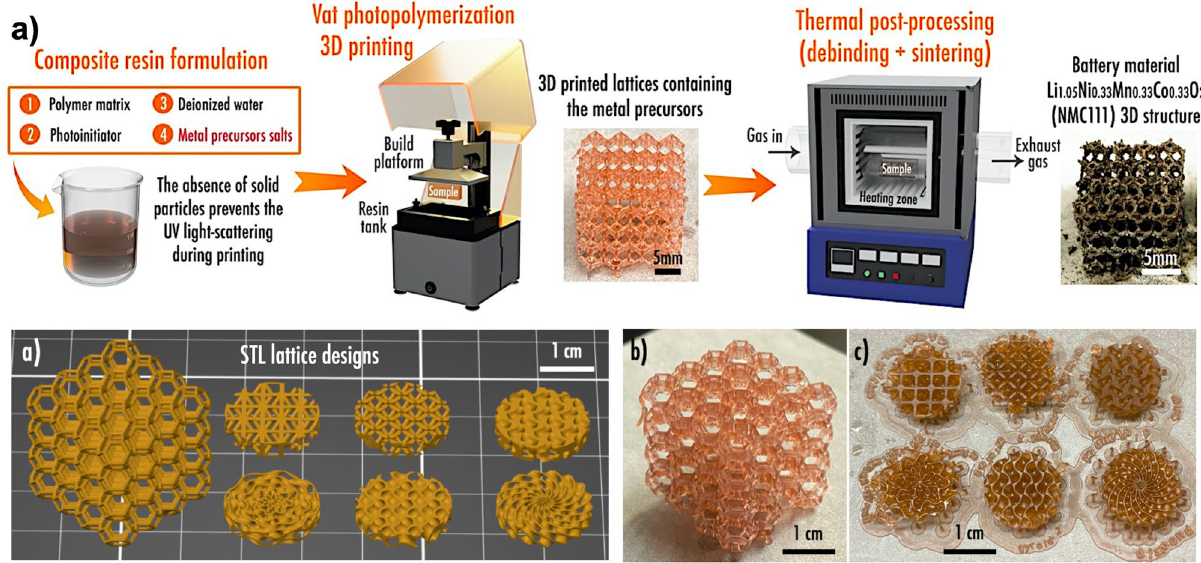
Figure 1. ( a ) Main steps of the NMC 111 3D structures fabrication process; ( b ) Standard Tessellation Language (STL) numerical models of the complex truncated octahedron and disc lattices with various infill patterns printed in this work; ( c ) actual 3D printed truncated octahedron and ( d ) discs, containing NMC 111 precursors.